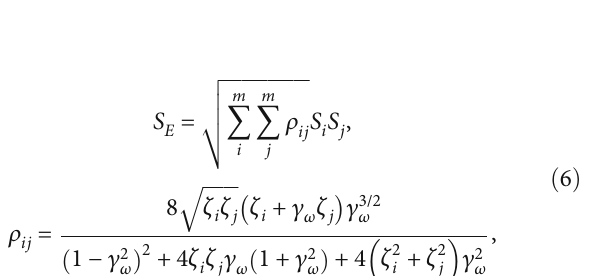
Figure 3: Finite element model of the side hole of a sluice.